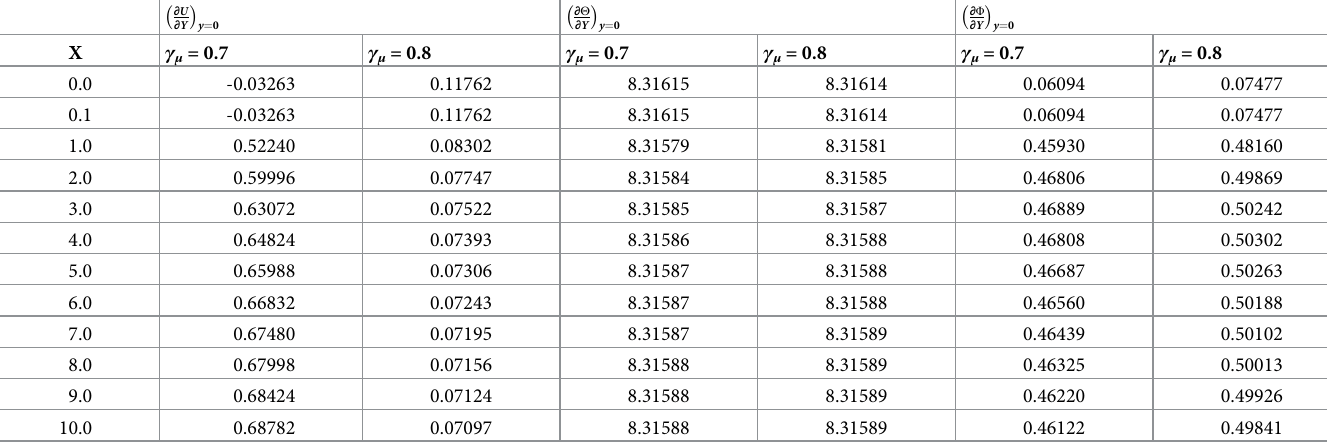
, ∂ θ and ∂ ϕ for different γ by keeping n = 0.5, Pr = 5.0, Sc = 0.8, E = 0.1, β = 0.8, γ = 0.8, λ = 0.2 and ξ = μ ∂ Y ∂ Y ∂ Y